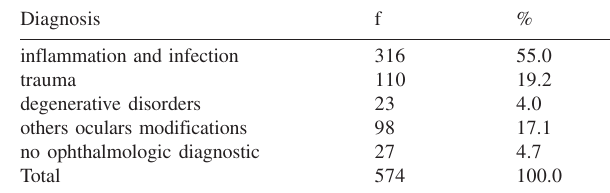
Table 1 - Main diagnostic categories of the patients that looked for ophthalmology emergency room of the University of São Paulo Medical School General